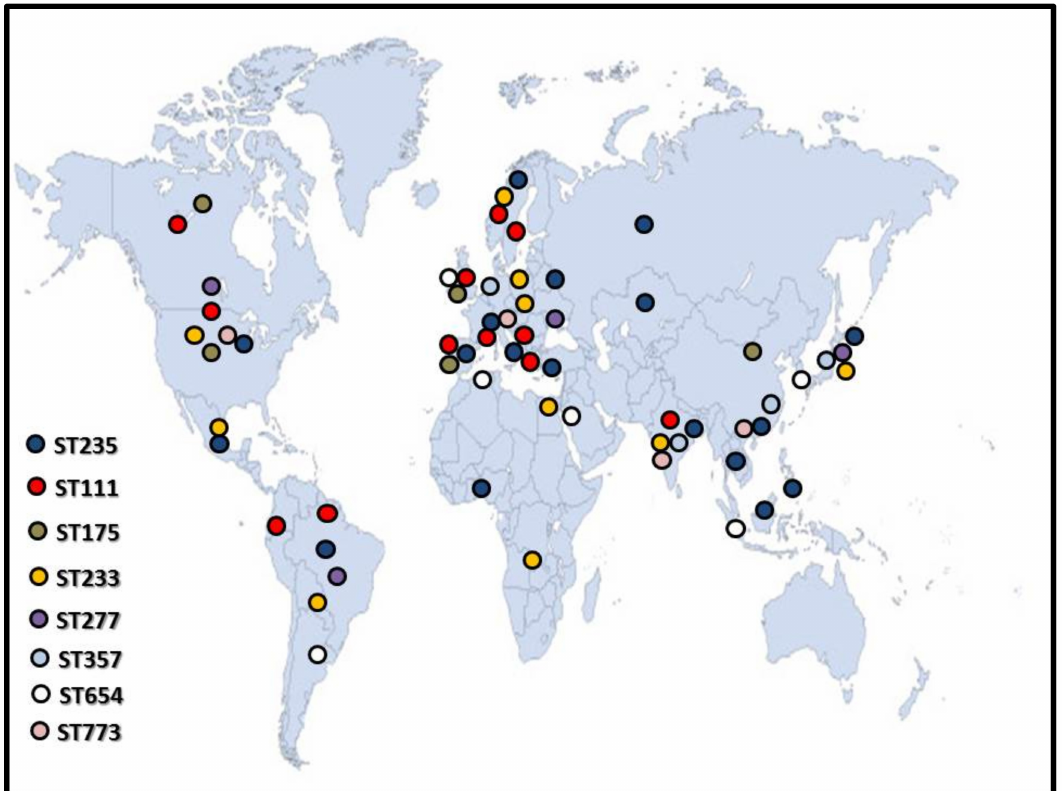
Figure 1. Geographic dissemination of the most frequently reported international high risk clones of P. aeruginosa. Figure illustrates reported cases until 2020. (source of map template: http://www.intrafor.com/locations-worldwide-presence. html, accessed on 23 January